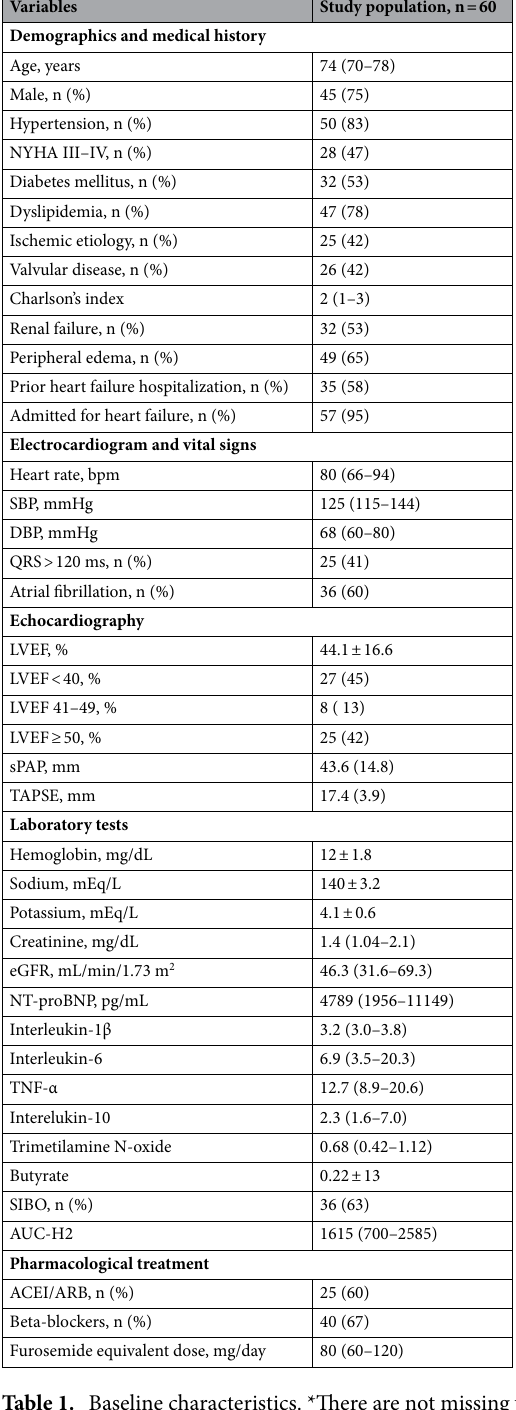
Table 1. Baseline characteristics. *There are not missing values in the variables listed in this table. Continuous variable are expressed as median (percentile 25–percentile 75) or mean ± standard deviation. NYHA